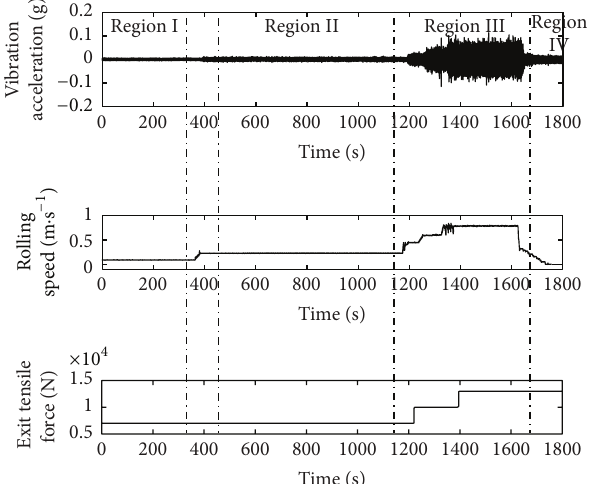
Figure21:Dynamicrollingexperimentunderdifferentexittensions and different rolling